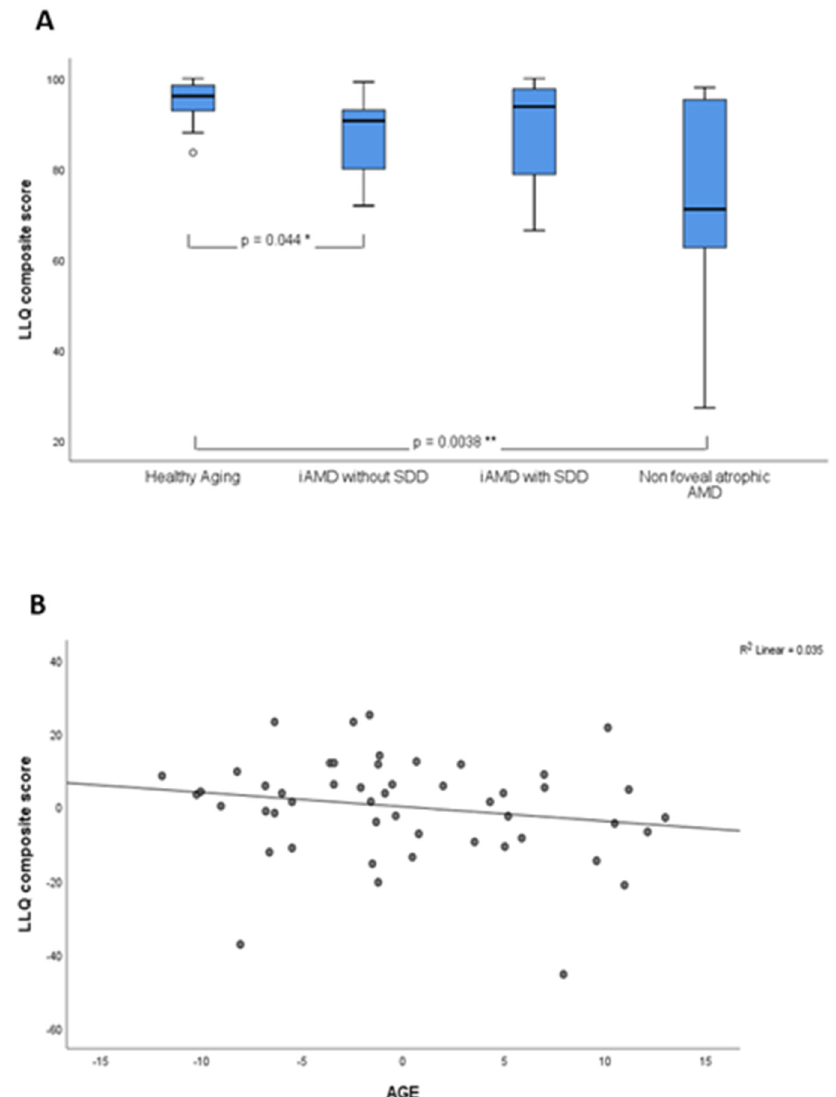
Figure 2. Low luminance questionnaire (LLQ) composite score shown as a function of disease and age. ( A ) Box plots showing LLQ composite score by disease group. Healthy aging (n = 11), iAMD without SDD (n = 17), iAMD with SDD (n = 11) and late AMD (n = 11). LLQ scores were statistically lower for the atrophic AMD group compared to healthy participants ( p = 0.0038) and modestly reduced between iAMD without SDD and healthy participants ( p = 0.044). ( B ) Linear regression showing the relationship of age against LLQ composite score in the full cohort after adjusting for disease ( β coefficient = − 0.390, R 2 = 0.035, p = 0.211).